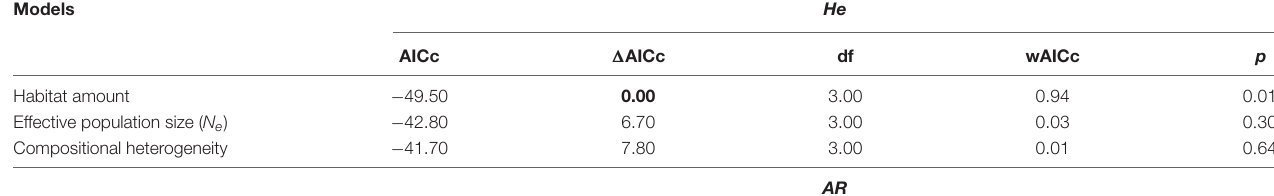
TABLE 2 | Model selection of the competing hypotheses to explain the patterns of variation in neutral genetic variability and adaptive quantitative traits, in populations of Tabebuia aurea in landscapes of the Brazilian Cerrado.